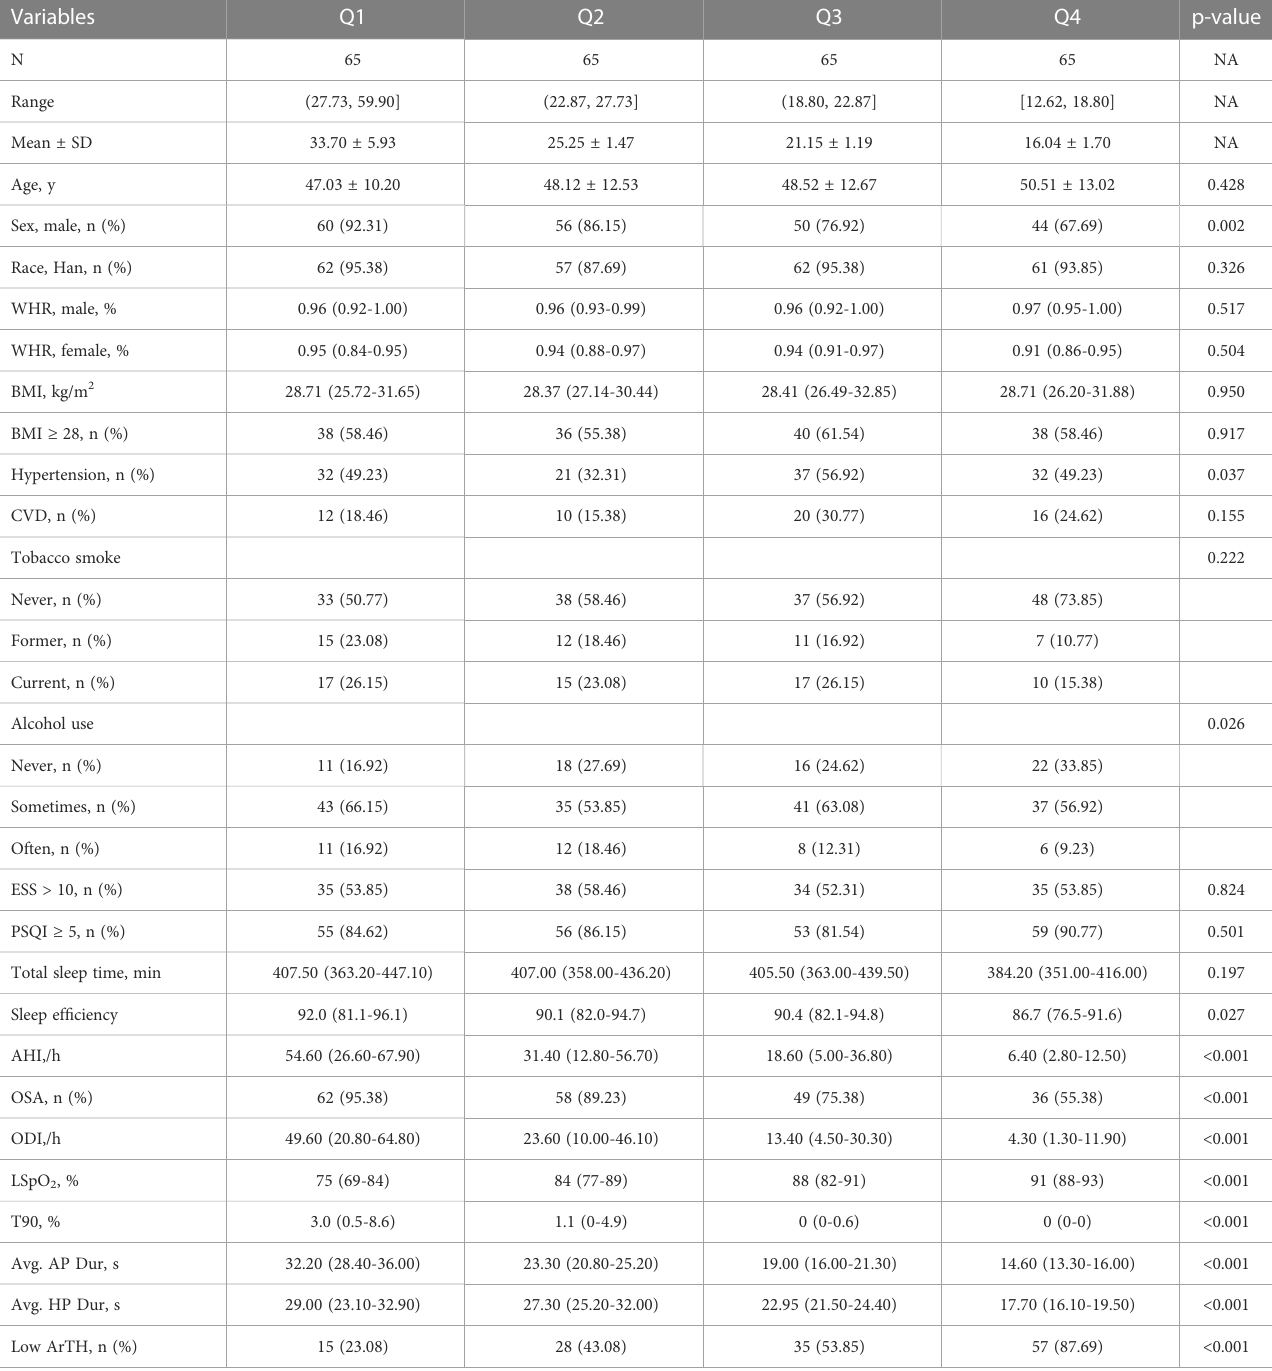
TABLE 1 Baseline characteristics by quartile of average respiratory event